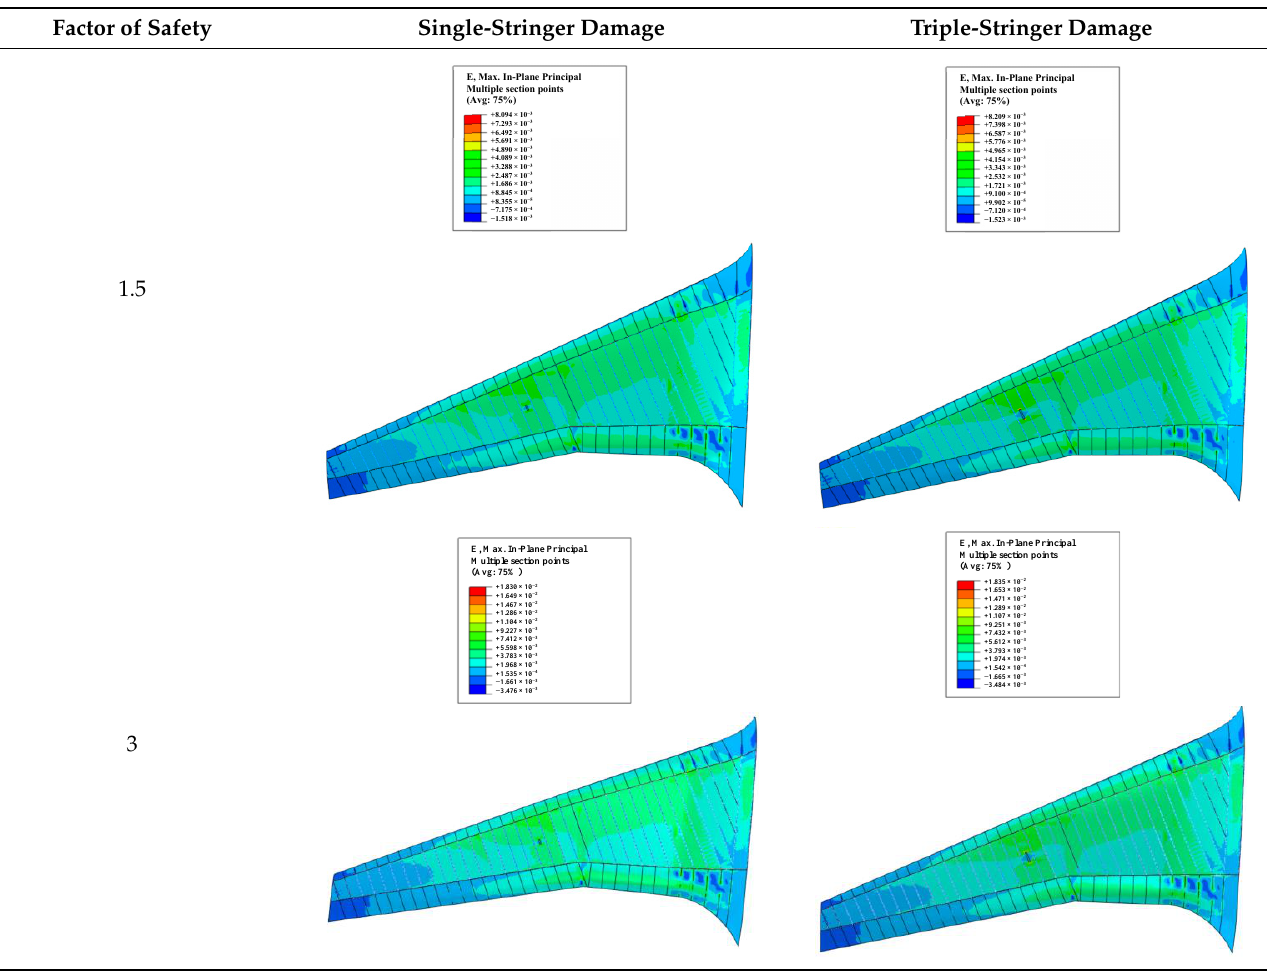
Results of Hashin fiber tensile failure criterion of single-stringer and triple-stringer